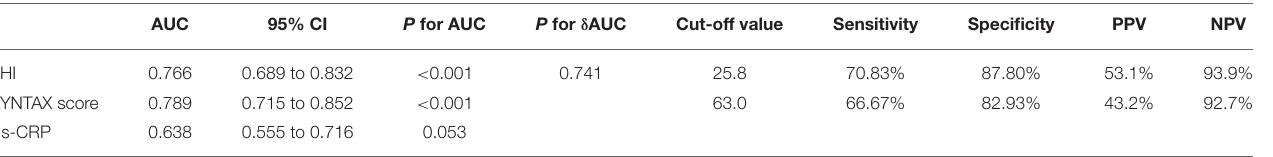
TABLE 6 | Predictive value of AHI, hs-CRP and SYNTAX score for PMI. AUC 95% CI P for AUC P for δ